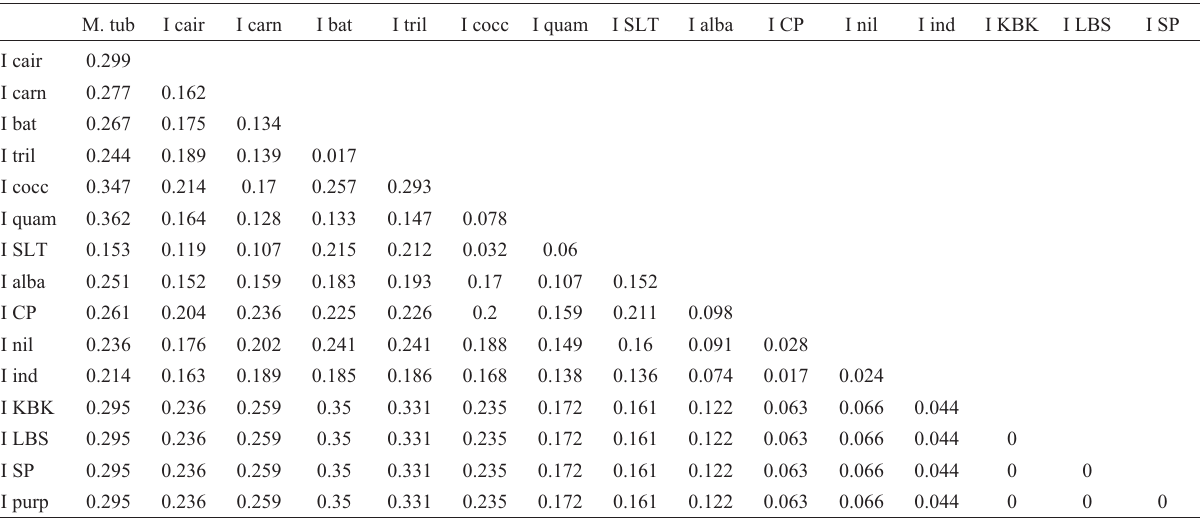
Table 3 - Nucleotide divergence analysis of ITS.